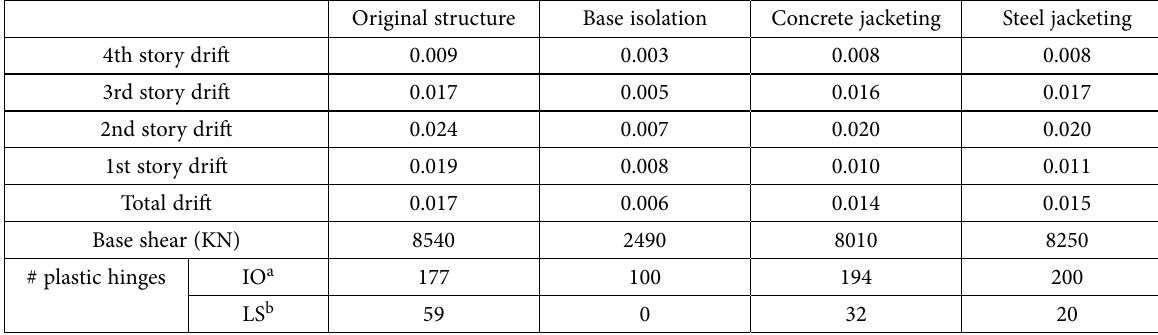
Table 1. Story drift, base shear, and number of plastic hinges